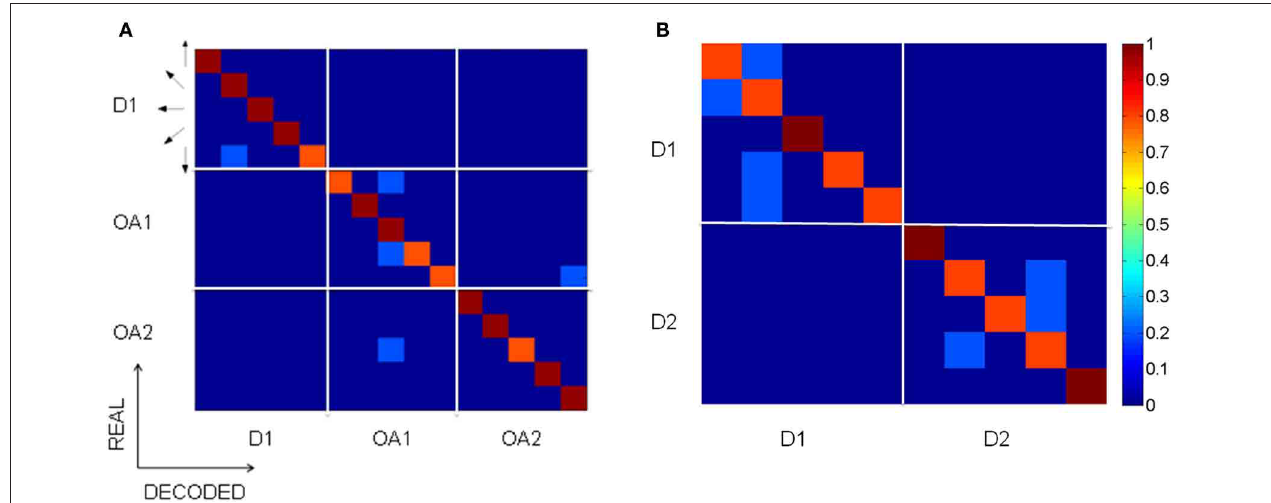
FIGURE 7 | Decoding analysis of MIP spiking activity within and across blocks. The confusion matrices show the percentage of trials accurately decoded. Arrows indicate the direction of the target relative to the starting position of the hand. (A) The matrices on the main diagonal show the predictions within conditions D1, OA1, and OA2. The off diagonal matrices